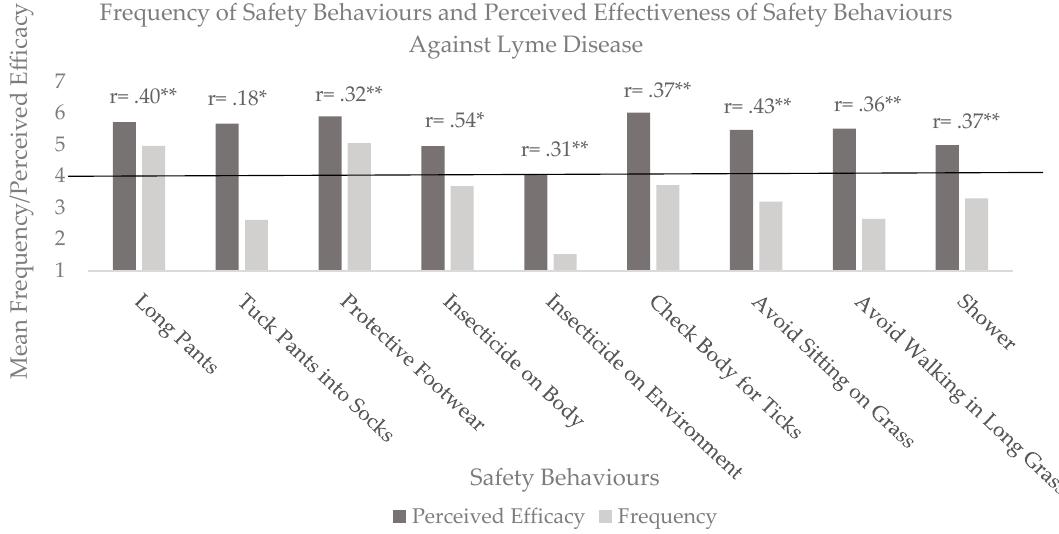
Figure 1. Mean ratings for frequency and perceived efficacy of safety behaviors. * p < 0.05, ** p < 0.01.